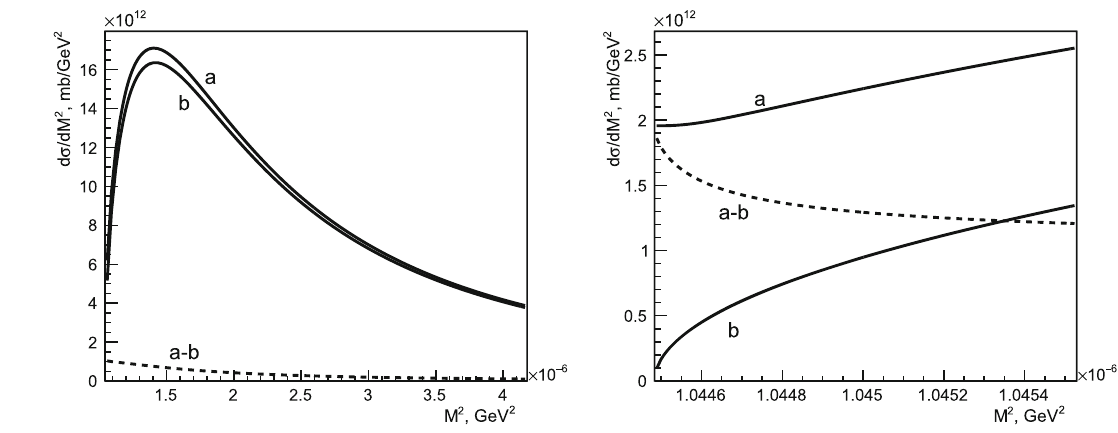
Fig. 1 The distribution of masses of dielectrons produced in ultrape- at the enlarged scale. Note the factor 10 − 6 at the abscissa scale which √ s nn =11 GeV with ( a ) and without ripheral collisions at NICA energy reduces it to MeVs. The GeV-scale is chosen here for further direct comparison with scales of the muon-pairs production at LHC shown in ( b ) account of the SGS-factor. Their difference ( a , b ) is shown by the Fig. 3 dashed line. The region of small masses is shown in the right-hand side